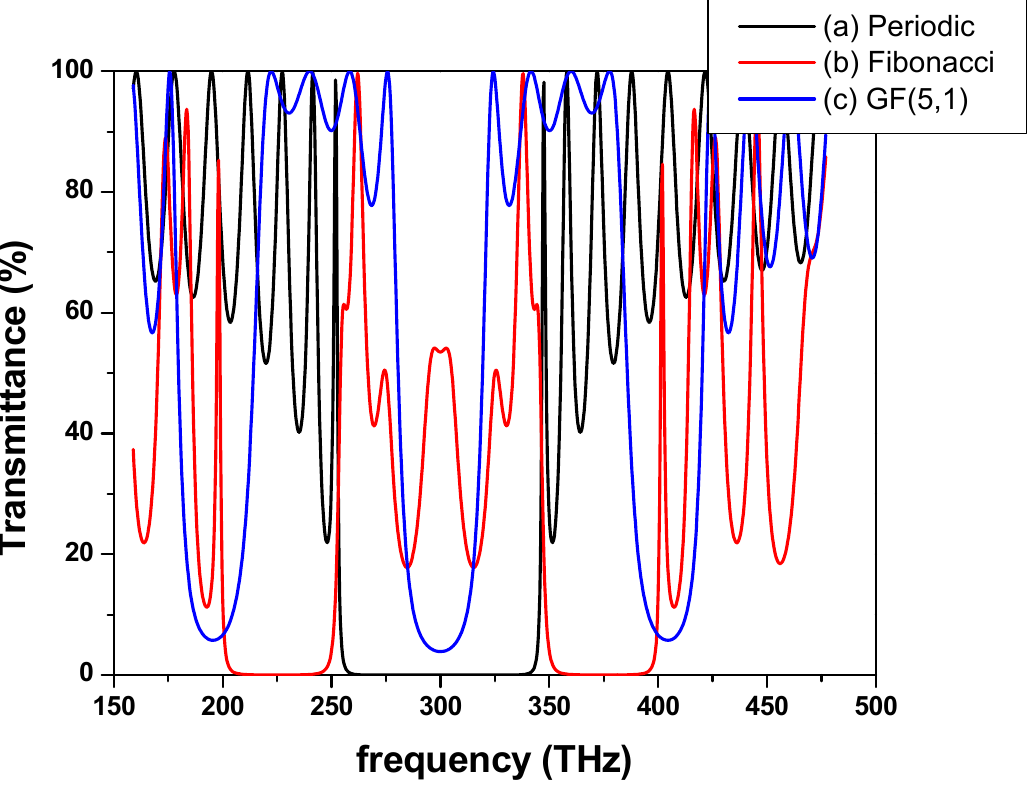
Figure 2. Transmittance spectra versus the frequency f (THz) for (a) periodic (34 layers, d = 4.78 µm), (b) Fibonacci (8 th iteration, 34 layers, d = 5.03 µm), and (c) GF (5, 1) (3rd iteration, 31 layers, d = 5.02 µm).